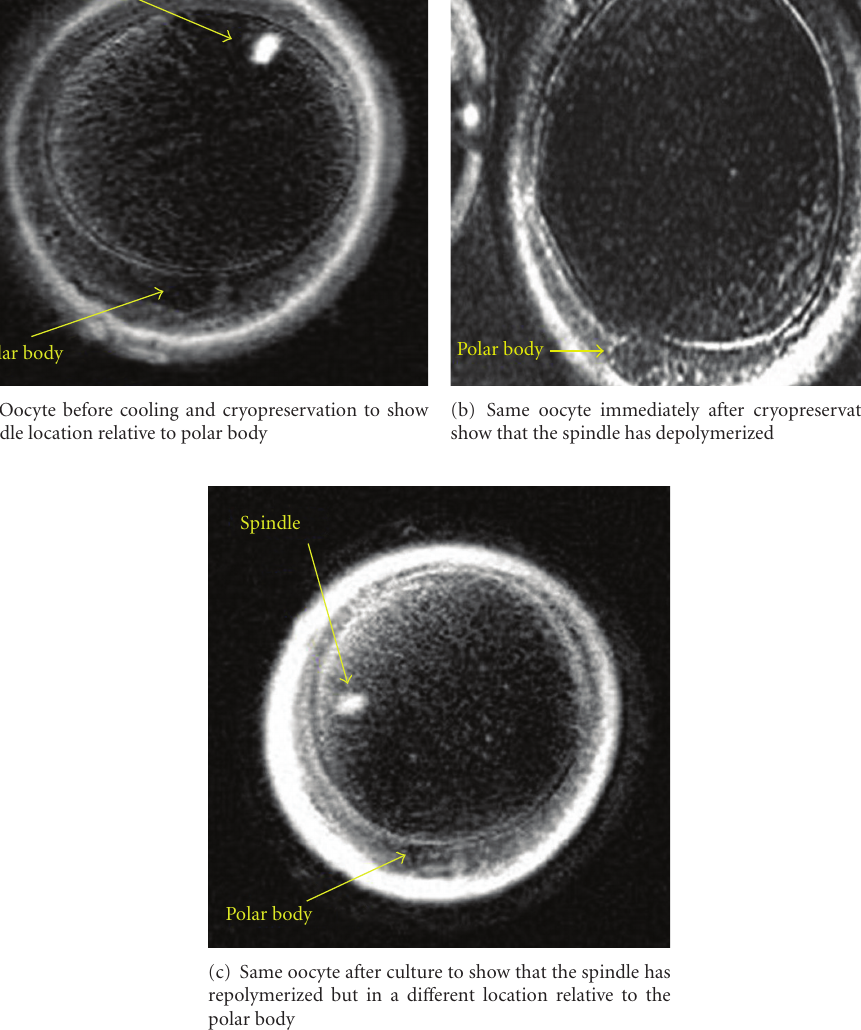
Figure 1: The sequence of the three figures of the same oocyte illustrates that the spindle and the polar body move relative to each other.